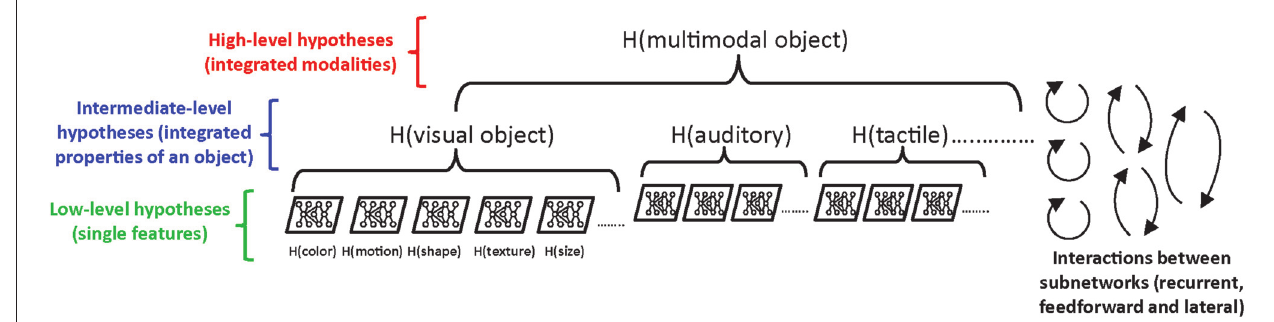
FIGURE 4 | The inferential account of conscious sensory processing. Illustration of the hypothesis that conscious sensory processing is organized according to low, intermediate and high representational levels (see Pennartz, 2015). In this scheme, representations correspond to predictions or hypotheses (rendered here as H( ... )). A low-level prediction or hypothesis (green) pertains to a singular feature within a sensory modality, pertaining to an object or location in the environment (e.g., H(color) is the hypothesis that a visual object is of a certain color). The intermediate level (blue) is exemplified by H(visual object), the hypothesis that a visual object has several properties integrated across the low-level predictions. The highest level of representation (red) integrates across several sensory modalities (vision, audition, somatosensory and (not shown) olfaction, taste, sense of balance) and is rendered here as the hypothesis on a multimodal object. For instance, a grabbing of a piece of paper in one’s hand generates a joint inference on its visual, tactile and auditory properties. Already at the lowest level, predictions are learned and generated within a feedforward and recurrent multi-layer architecture which may well stretch across several connected cortical areas (e.g., V1, V2, V3 and V5 for visual motion). Note that motor or situational aspects, including the object’s position in space, are not taken into account in this scheme. In addition, a prediction on one particular feature × may well depend on predictions on other features y and z (etc.), for instance when assessing object shape from colored patches, texture and disparity cues. Thus, hypotheses are can be conditional on each other, which may be implemented by interactions between sub-networks. Horizontal dotted lines denote that the potential list of relevant features or sensory modalities can be extended. Curved arrows indicate the various types of interaction between sub-networks (recurrent, feedforward and